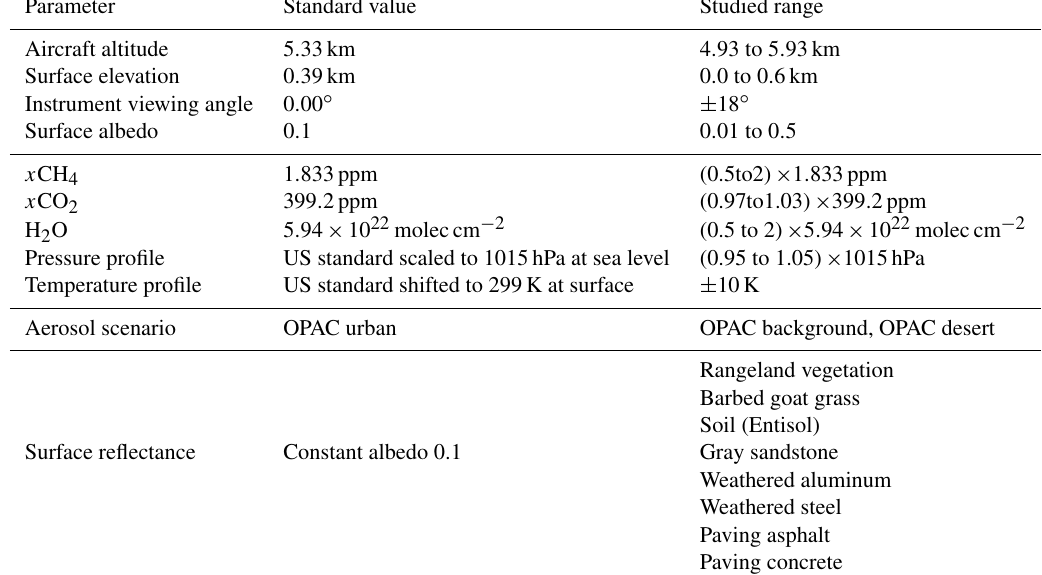
Table 2. Parameters studied in the sensitivity analysis and the range in which deviations were analyzed. The second column shows the back- ground scenario used as “truth” in the sensitivity study. The third column notes the range of the perturbation of the parameters. Parameters not mentioned here were constant and estimated as described in Sect. 3.1 for the flight line